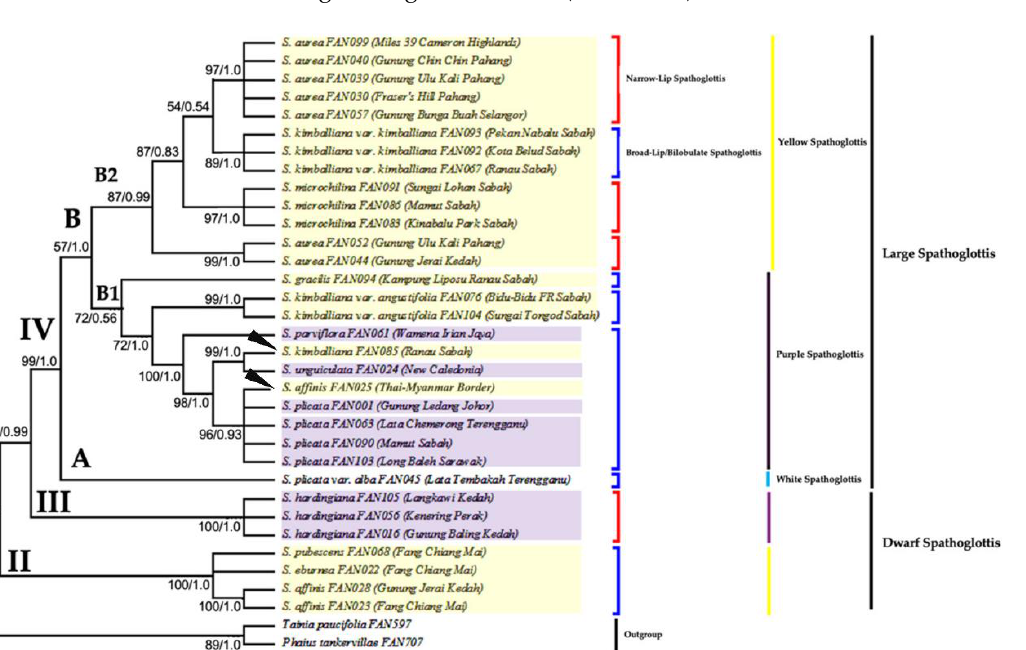
Table 4. Sequence data analysis of ITS1, 5.8S and ITS2 regions in 11 species and three infraspecific taxa of Spathoglottis.